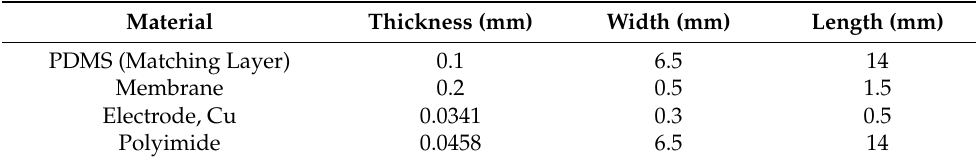
Table 1. Parameters for all simulated